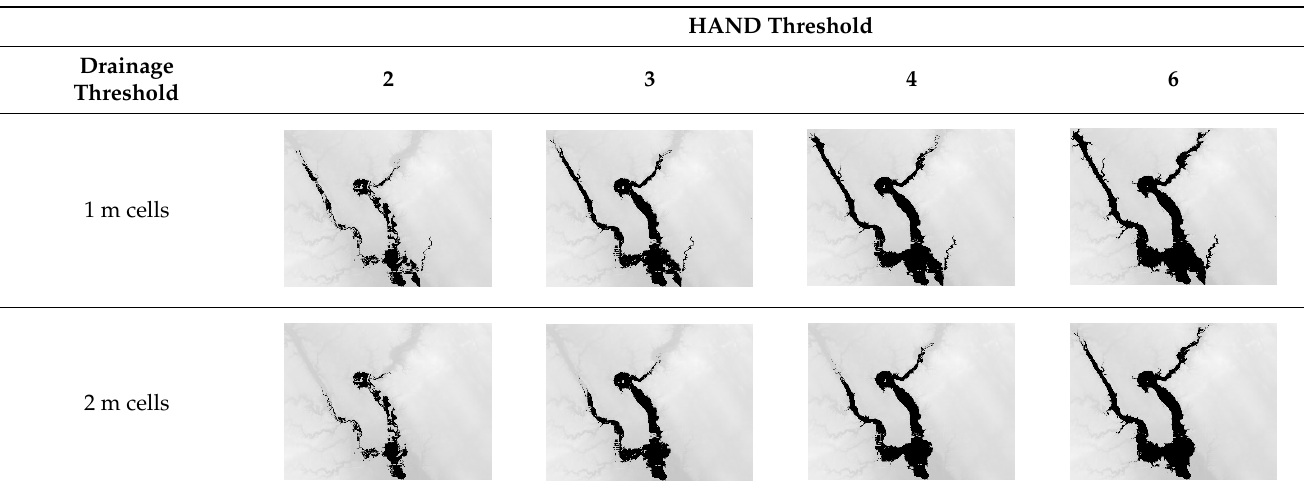
Table 2. Sensitivity of model parameters (HAND threshold and drainage threshold) on the resulting flood extent (absolute threshold 225 ft).